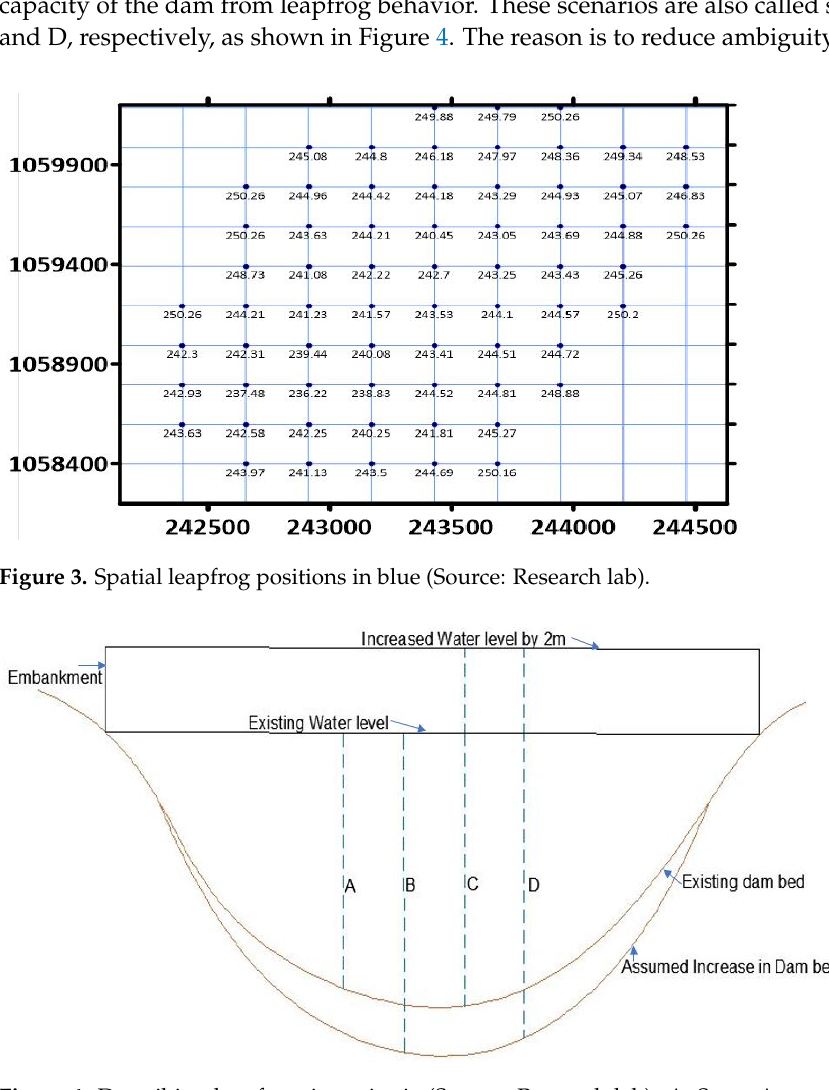
Figure 4. Describing leapfrogging criteria (Source: Research lab). A: Stage A was taken to be the present state of the dam (leapfrog at rest) with space covered. Knowing the spatial information (X, Y, and depth) of all the leapfrogs, the volume occupied was computed. B: At Stage B, it was assumed that the leapfrogs dug downward 2 m from their existing water-based level (dam bed). Thus, the depths were increased downward independently by 2 m and the capacity determined. C: Additionally, at Stage C, it was assumed that the leapfrogs leapt upward above the present water level by 2 m. Hence, the depth was increased above the current level by 2 m. The embankment, as shown in this figure, is a presentation of the increase. Consequently, the volume was calculated. D: Furthermore, at Stage D, the whole scenario (A, B, and C) was considered and the cumulative volume was